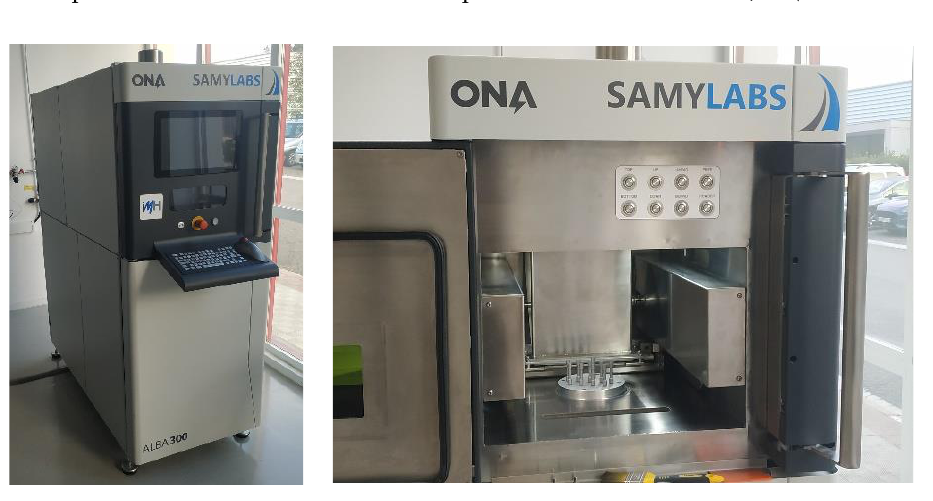
Figure 2. Manufacturing path strategy: layer path and part path.